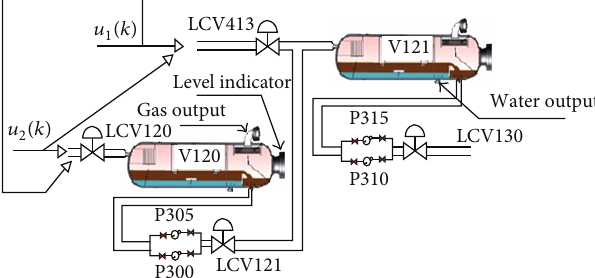
Figure 2: Oil circuit diagram of the considered interconnected hydraulic system.